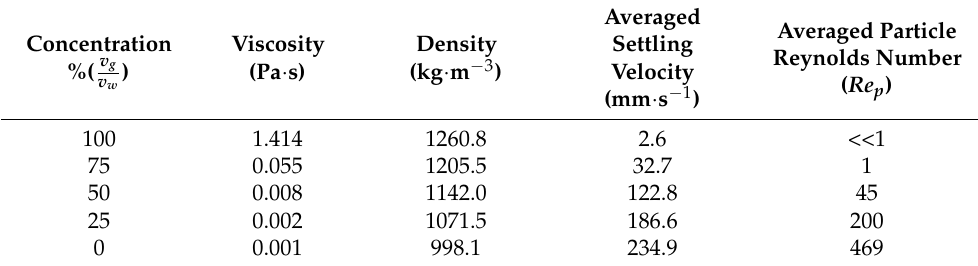
Table 1. Characterization of dual settling particles’ averaged Reynolds number for a 0.25D initial separation